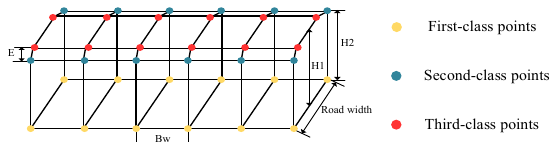
Figure 3. Sketch of non-obstruction space construction: multiple boxes form the non-obstruction space.